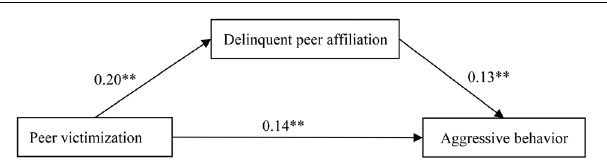
FIGURE 2 | Model of the mediating role of delinquent peer affiliation between peer victimization and aggressive behavior. Non-significant paths, and paths between gender, age, impulsivity, and each of the variables in the model are not displayed. Of those paths, the following were significant: gender, age and impulsivity to delinquent peer affiliation ( b 1 = 0.12 ∗∗ , b 2 = 0.02 ∗∗ , b 3 = 0.15 ∗∗ ) and aggressive behavior ( b 1 = 0.10 ∗∗ , b 2 = 0.01 ∗∗ , b 3 = 0.36 ∗∗ ). ∗ p < 0.05, ∗∗ p < 0.01.